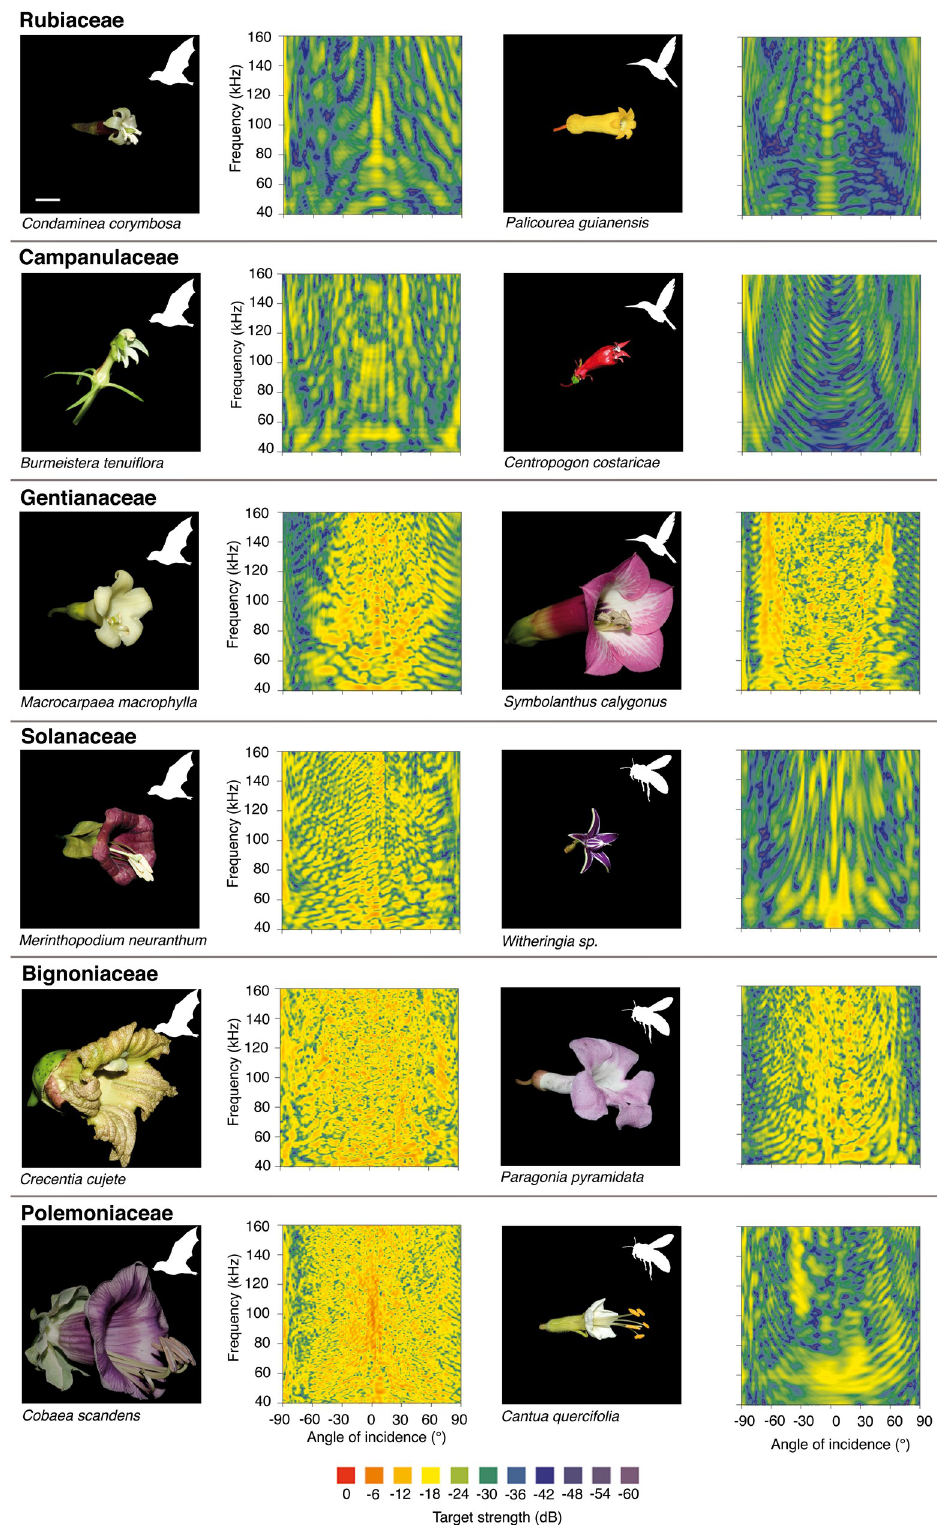
Fig 1. Images and directional spectra of flowers from 6 different plant families. As a visual representation of the flowers’ echo characteristics, the echo spectra were plotted over the angle of sound incidence, which resulted in